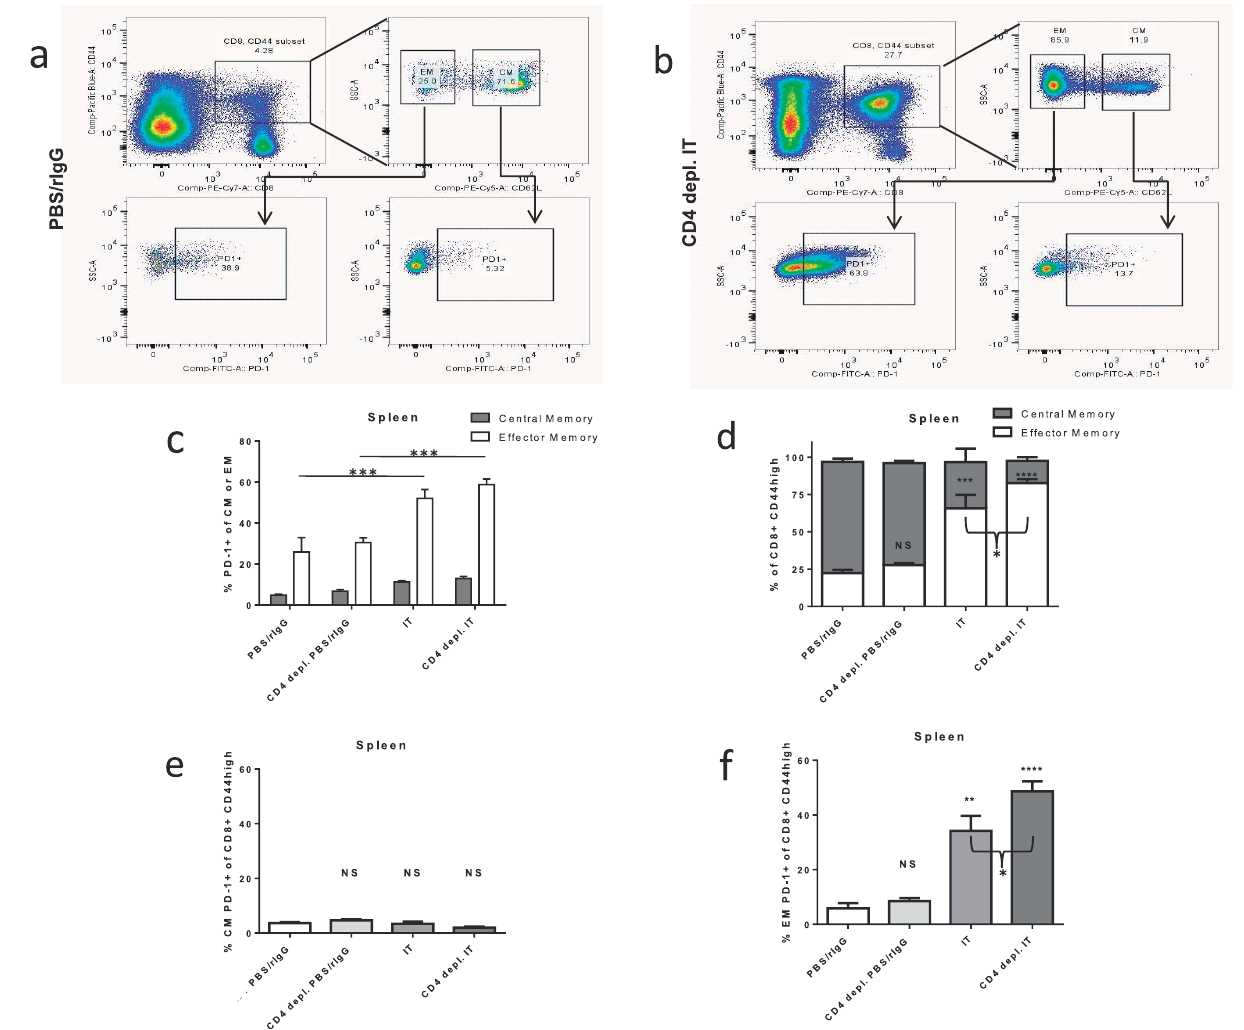
Figure 7. PD-1 expression on central and effector memory CD8 + T cells after IT in CD4 + T cell depleted mice. Control or CD4 + depleted C57BL/6 mice were treated with IT or PBS/rIgG (control). CD62L and PD-1 expression on memory T-cells was quantified by flow cytometric analysis 11 days after the initiation of IT. ( a,b ) Examples of the gating strategy for PD-1 expression on the CM and EM components of the memory CD8 + T cell compartment. The majority of cells in the memory compartment are CM in untreated mice ( a ) and EM in IT treated mice ( b ). ( c ) PD-1 expression on CM and EM cells. ( d ) The composition of the memory CD8 + T cell compartment in control or CD4 depleted mice treated with IT or PBS/rIgG. PD-1 + CM cells ( e ) and PD-1 + EM cells ( f ) as a percentage of the total memory CD8 + T cell compartment. Results are representative of two to three independent experiments with 3 mice per group (* P , .05, ** P , .01, *** P , .001, **** P , .0001).